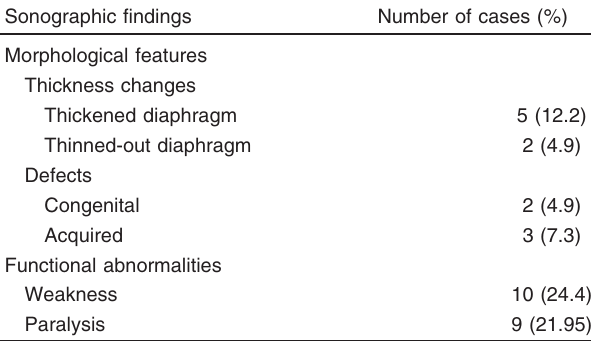
Table 1 Sonographic findings in patients with intrinsic diaphragmatic abnormalities (total number of patients with diaphragmatic abnormality = 41) Sonographic